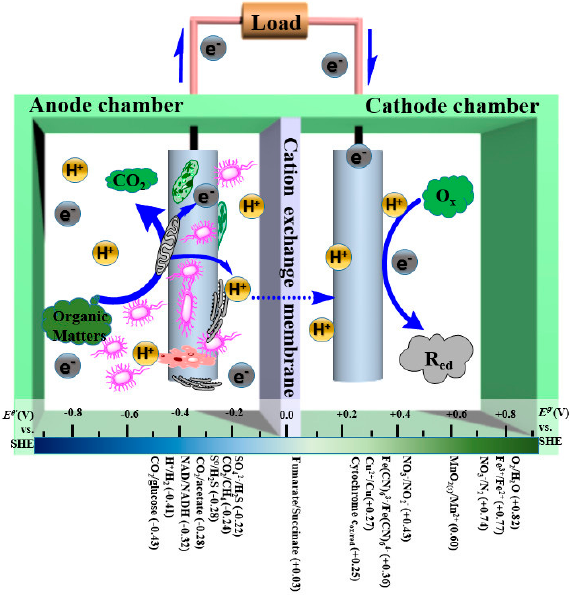
Figure 12. Fundamental configuration of microbial fuel cells with the redox potential of various electron acceptors and donors at pH = 7.0.